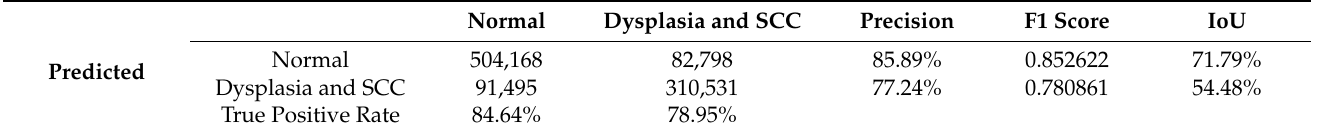
Table 2. Confusion matrix for white-light